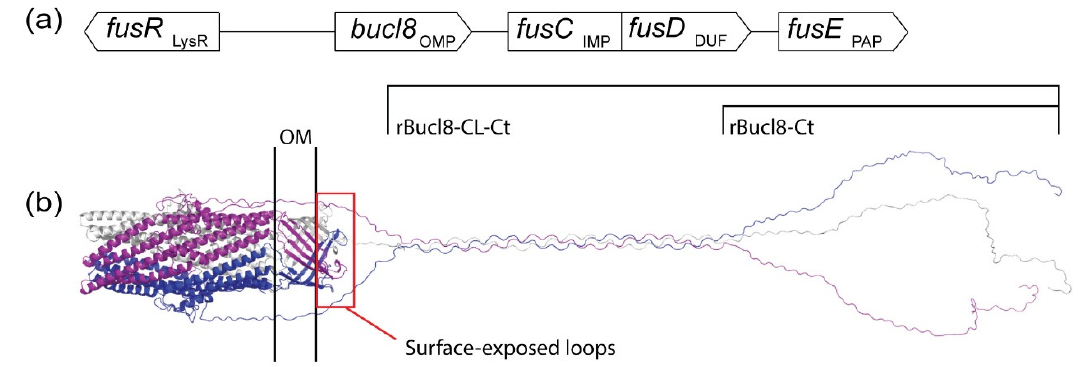
Figure 1. Bucl8 modeling and immunogenicity of Bucl8-derived antigens. ( a ) Schematic of genes in bucl8 operon. Indicated gene products: LysR, LysR-type transcriptional regulator; OMP, outer membrane protein; IMP, inner membrane protein; DUF, domain of unknown function; PAP, periplasmic adaptor protein. ( b ) Homology model of Bucl8 variant in B. pseudomallei and B. mallei . Bucl8 trimeric structure is shown, with chains colored in blue, grey, and magenta. Bacterial outer membrane (OM) and the surface-exposed loops of Bucl8 are marked. Bucl8-derived recombinant proteins rBucl8-CL-Ct, which includes both the triple helical collagen-like domain (CL) and C-terminal domain (Ct), and rBucl8-Ct, containing only the unstructured C-terminal domain, are indicated. Homology modelling was performed with MODELLER, using the VceC structure (PDB code 1yc9) as a template for the periplasmic/outer membrane component and the high-resolution structure of the collagen-like peptide (PDB code 1k6f) as a template for the CL region.